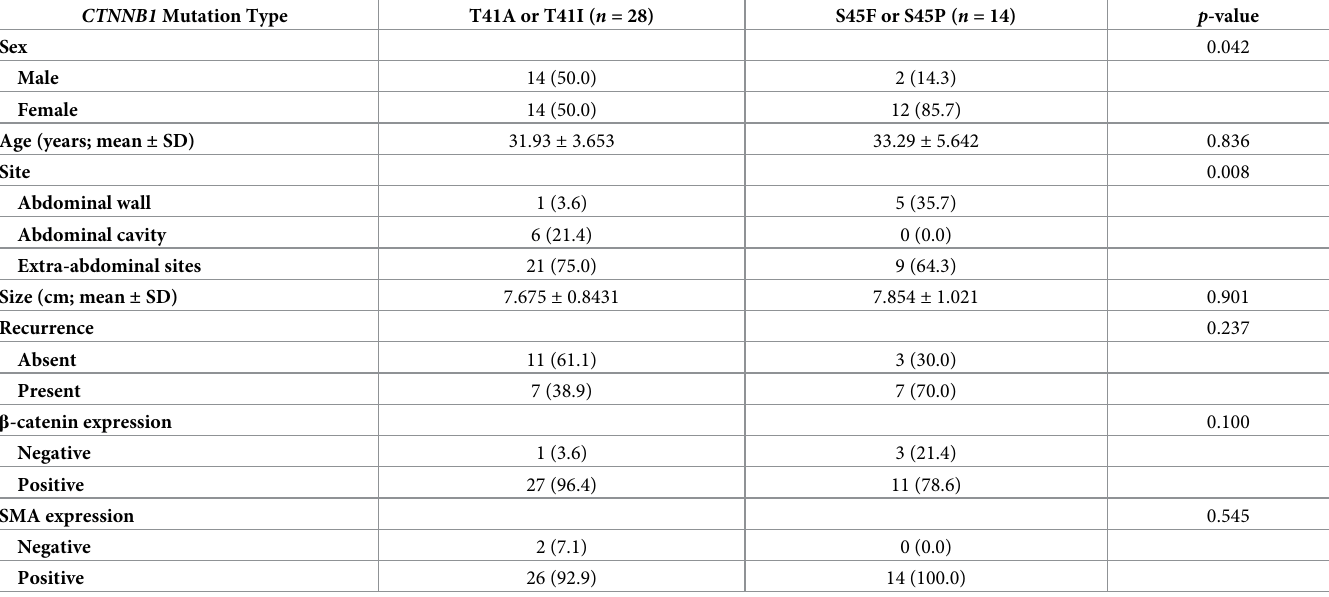
Table 5. Clinicopathological findings in desmoid-type fibromatosis patients according to CTNNB1 mutation types. CTNNB1 Mutation